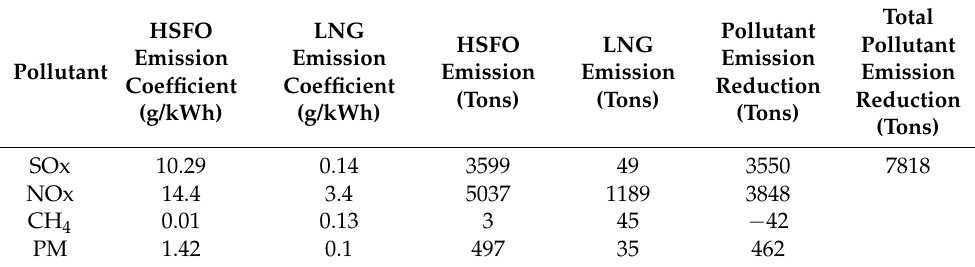
Table 14. Pollutant emission reductions of the LNG strategy in the first